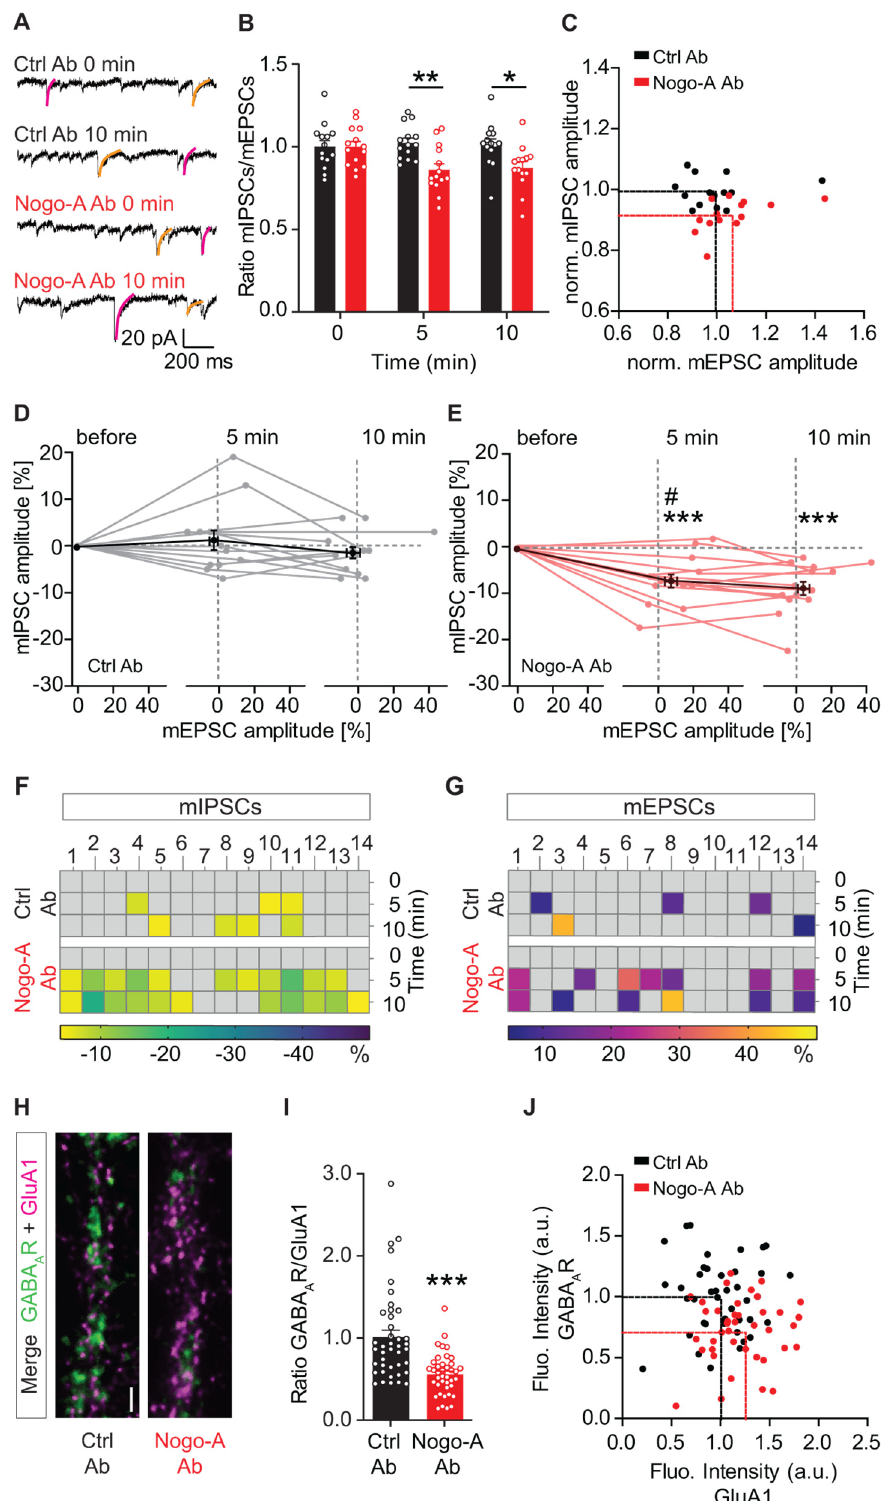
Figure 1. Nogo-A loss-of-function shifts the excitation/inhibition balance toward a higher excitation at a single cell level. ( A – C ) Patch-Clamp recordings in organotypic hippocampal cultures of simultaneously measuring mEPSCs and mIPSCs before (0 min) and after (5–10 min) control antibody, in all experiments mouse IgG1, FG12 (black, n = 14) or Nogo-A mouse IgG1, 11C7 function-blocking antibody (red, n = 14) treatment. ( A ) Example traces of mPSCs recorded by whole-cell patch clamp. Each trace shows representative mEPSCs (magenta) and mIPSCs (orange) distinguished by their